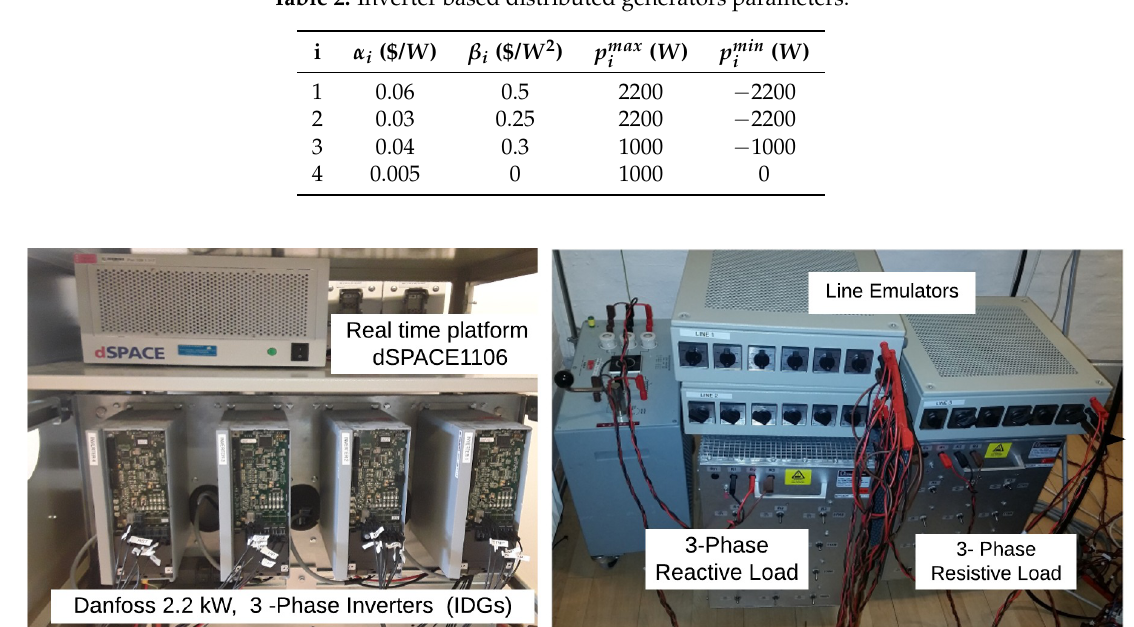
Table 2. Inverter based distributed generators parameters.